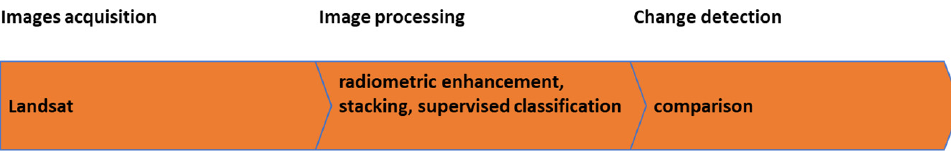
Figure 4. Land use classification protocol using Landsat images.